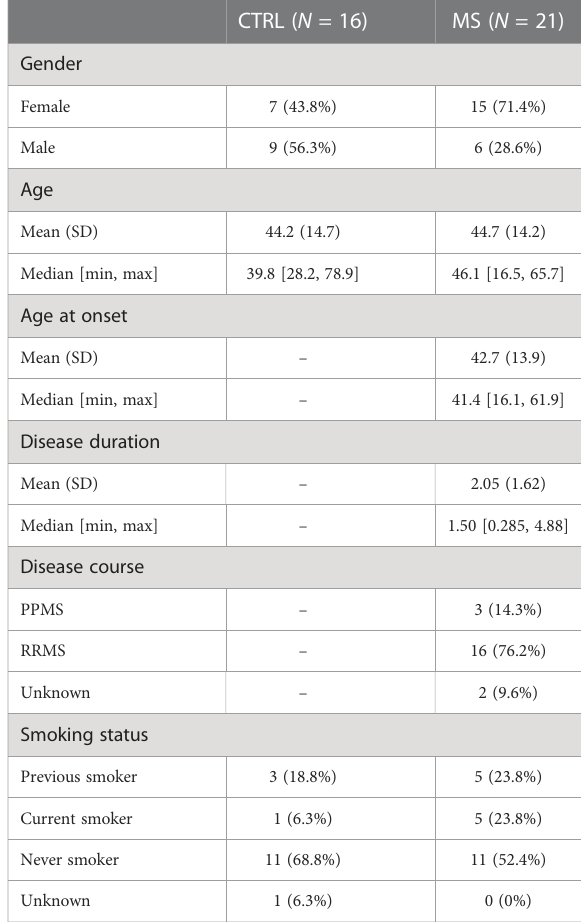
TABLE 1 The study participants ’